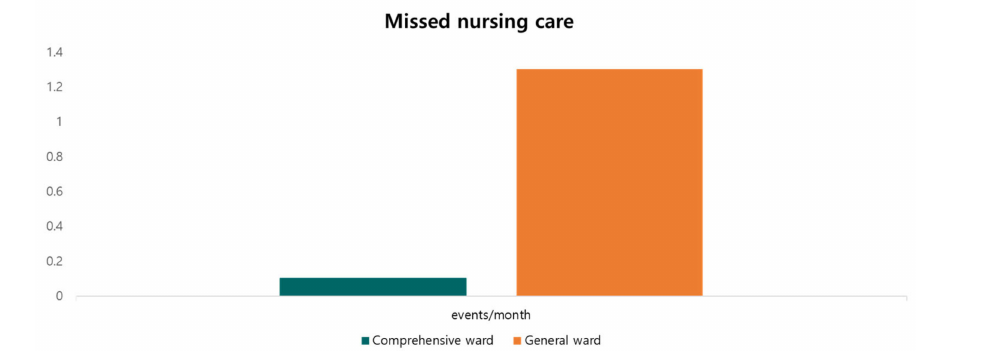
Figure 2. Missed nursing care